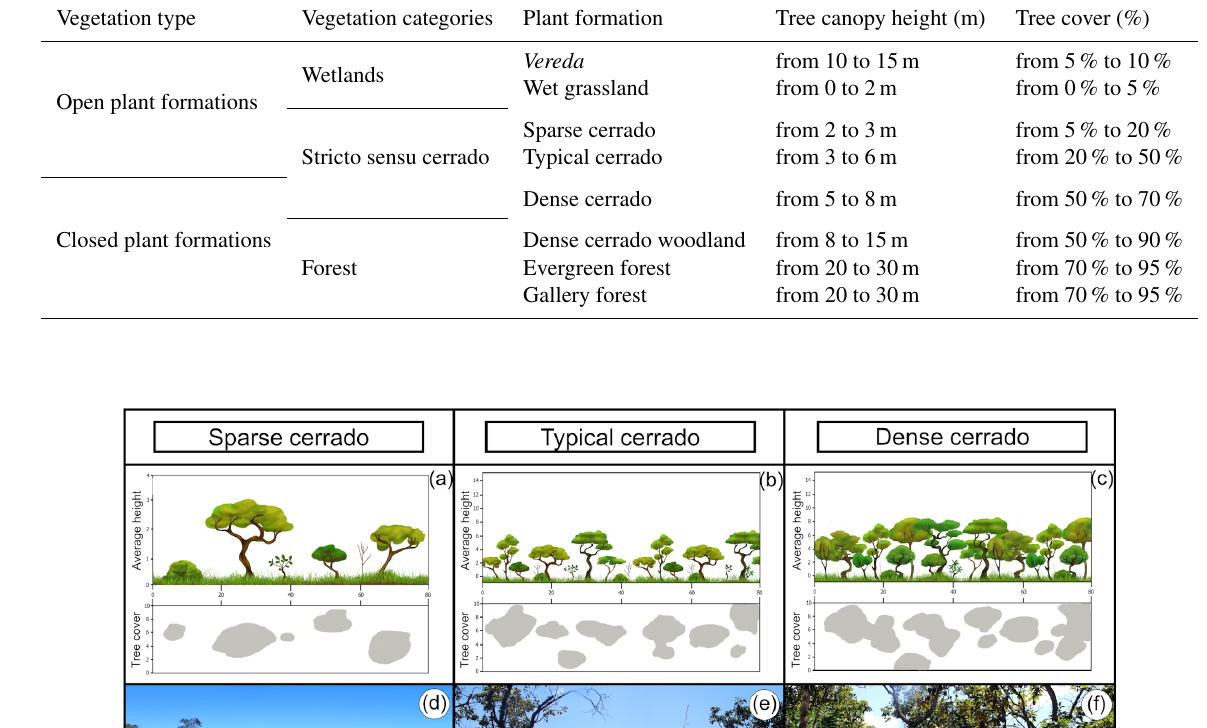
Table 1. Vegetation classification of PES and their respectively characteristics (according to Ribeiro and Walter, 2008; Neves et al., 2019; Schwieder et al., 2016).